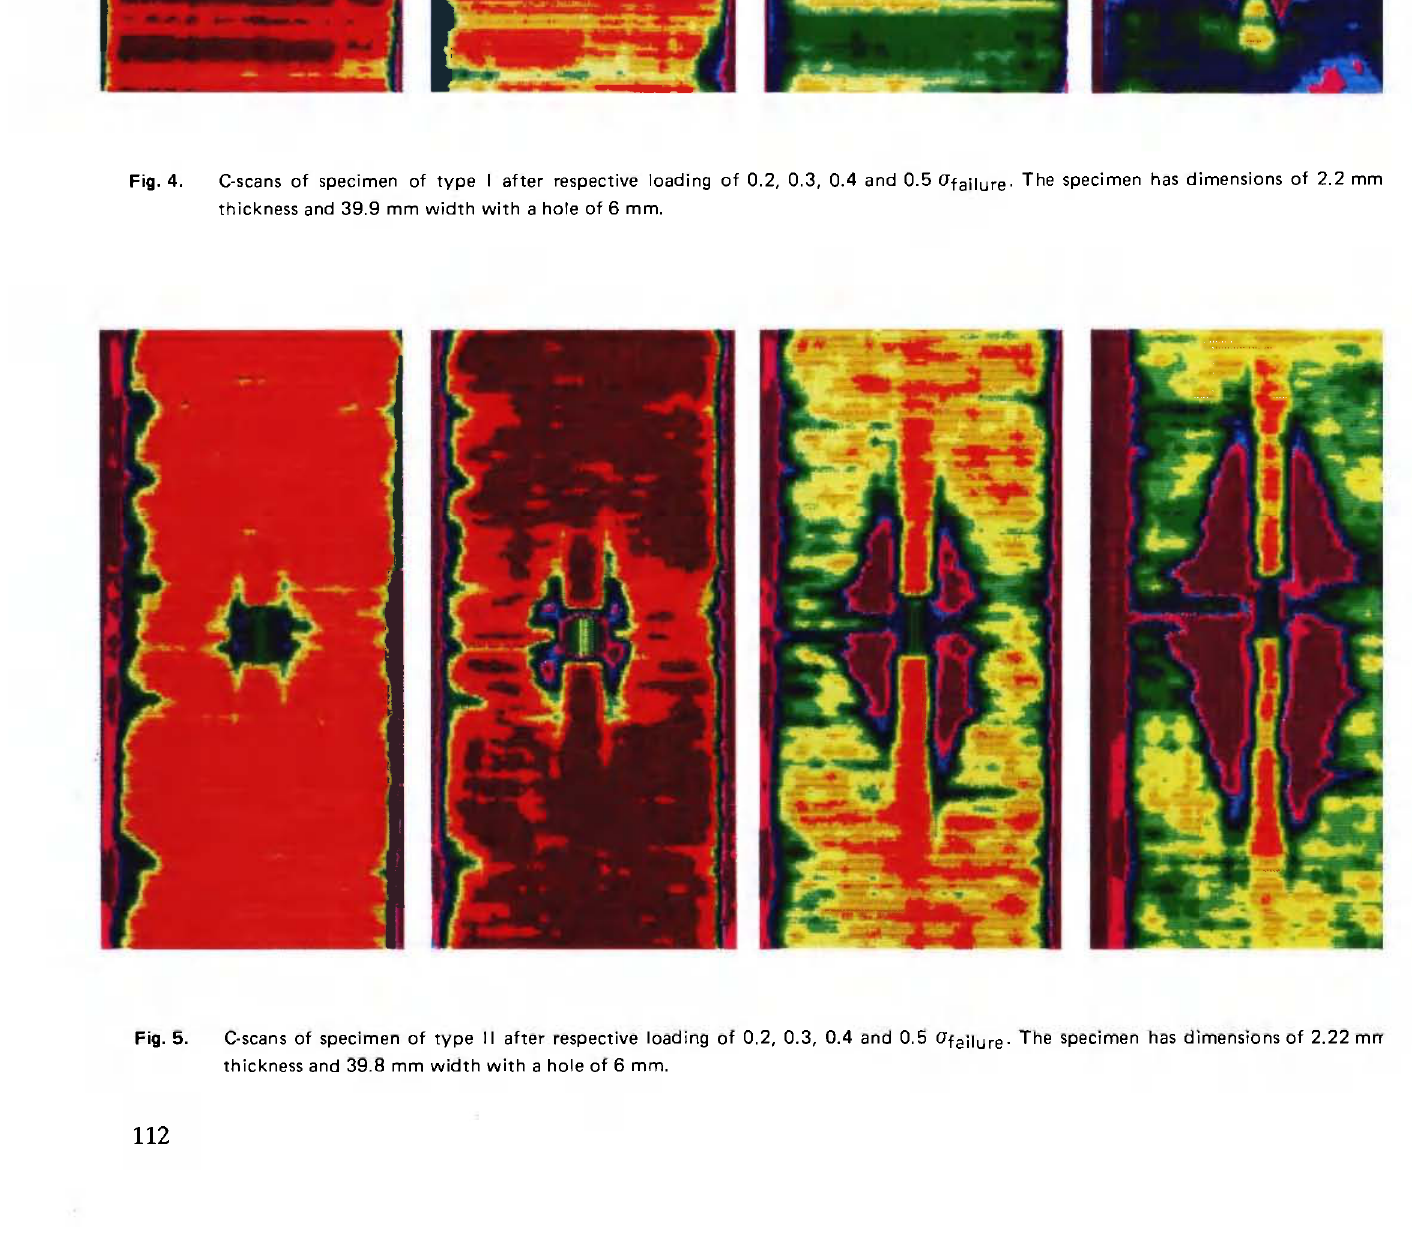
Fig. 4. C-scans of specimen of type I after respective loading of 0.2, 0.3, 0.4 and 0.5 C7f a j| ure . The specimen has dimensions of 2.2 mm thickness and 39.9 mm midth with a hole of 6 mm.